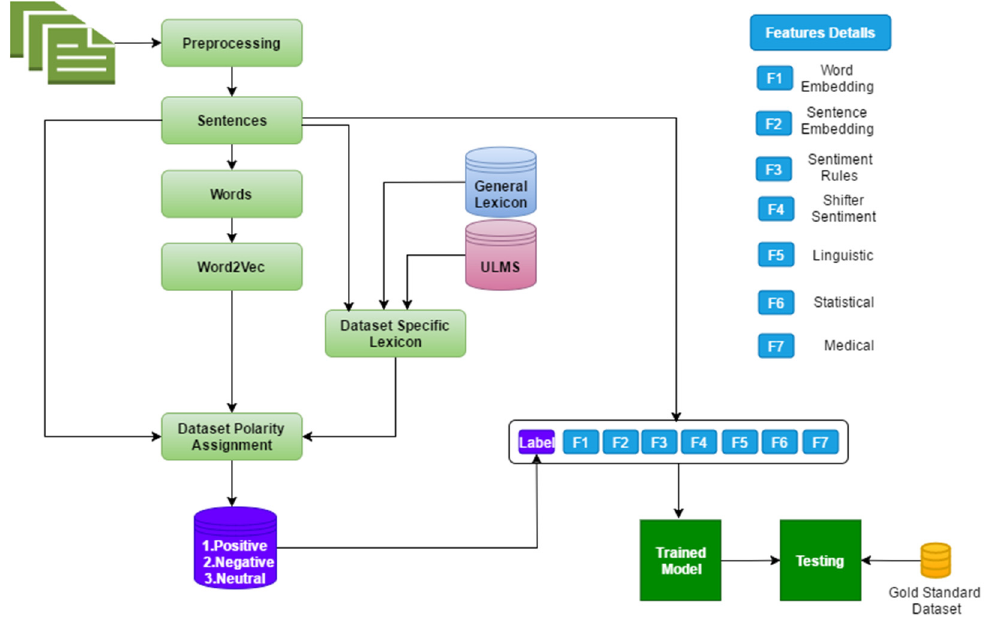
Figure 1. Steps of the proposed method.